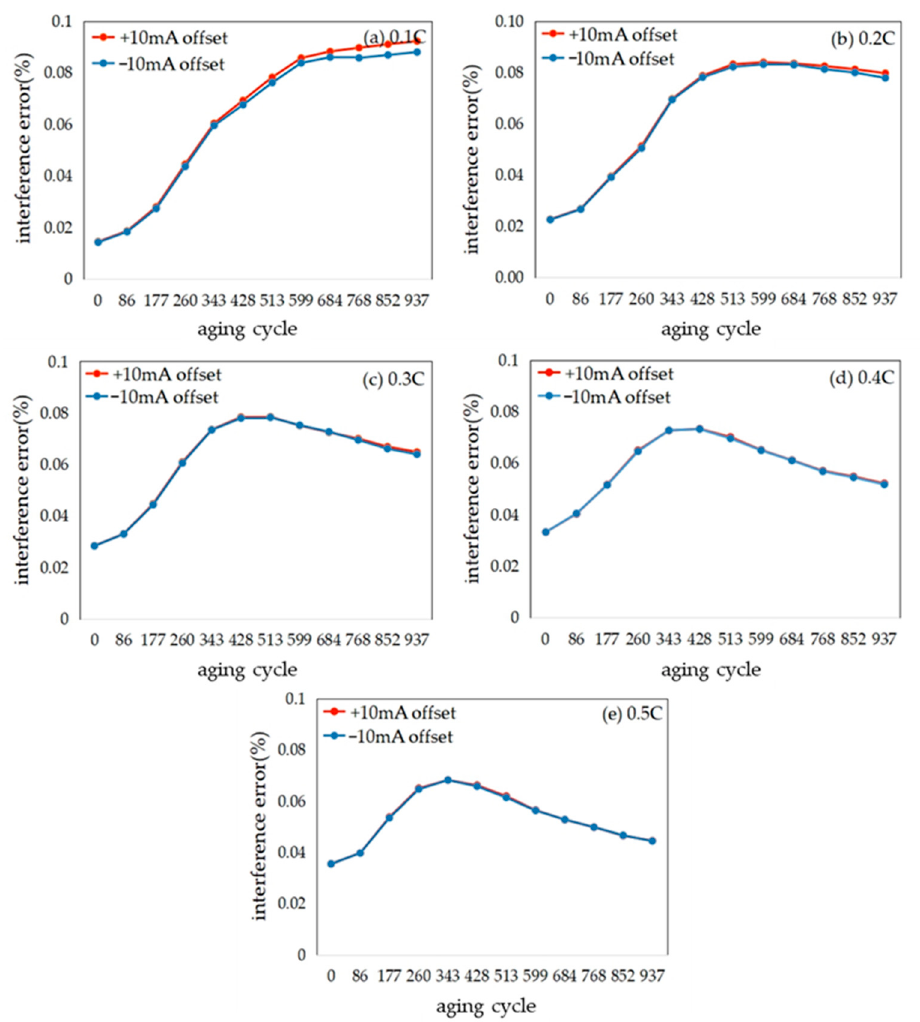
Figure 9. Interference error generated by ± 10 mA offset of the data-driven method.